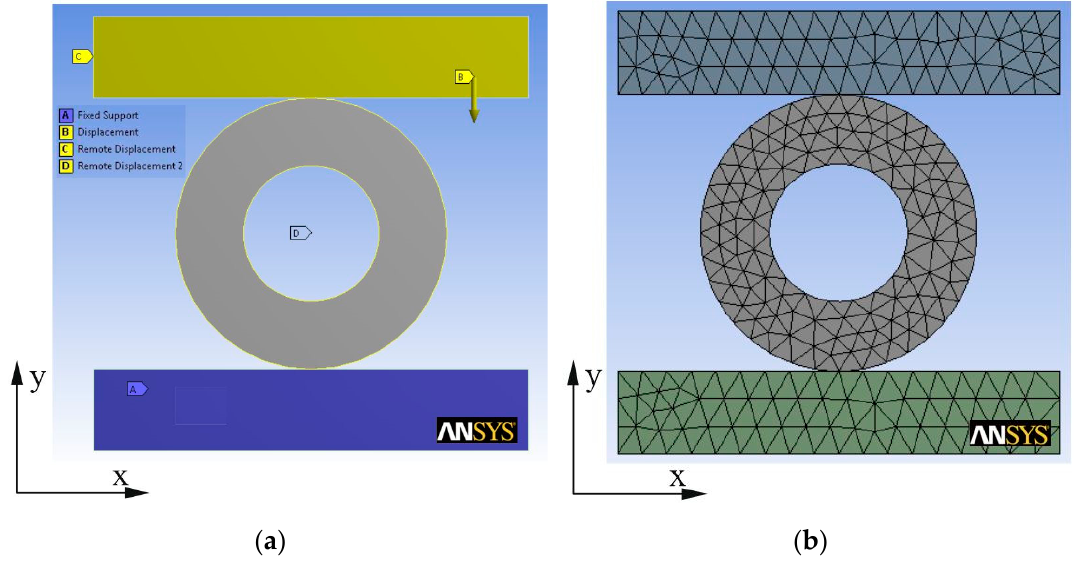
Figure 3. Numerical model of a cylindrical fender. ( a ) Boundary conditions; ( b ) Model discretiza- tion.